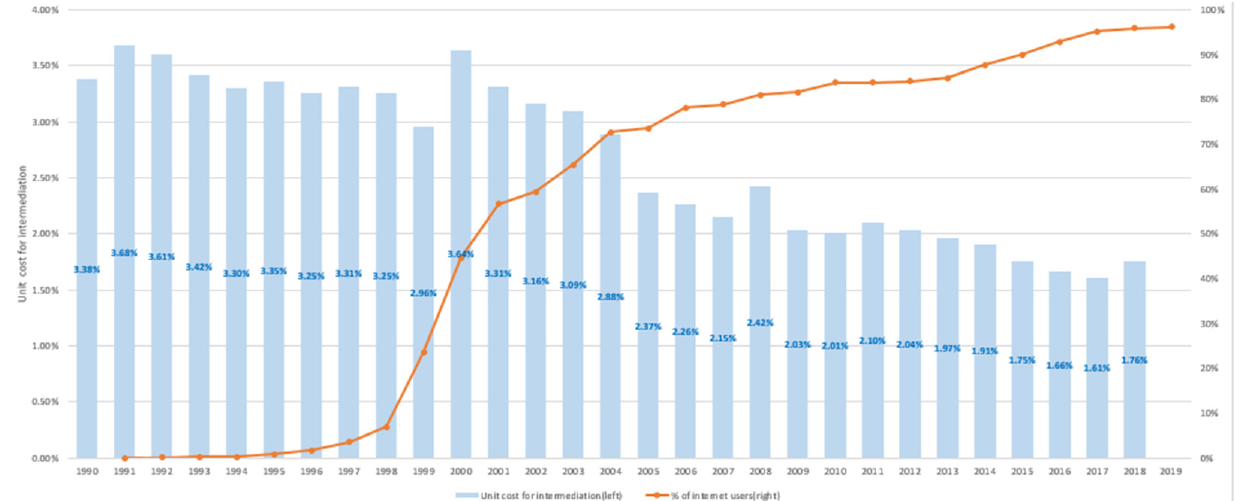
Figure 5. Impact of digital transformation and unit cost for intermediation. Source: Author compilation quoted in (Bank of Korea 2020; Korea Statistics Information System (KSIS) 2021).